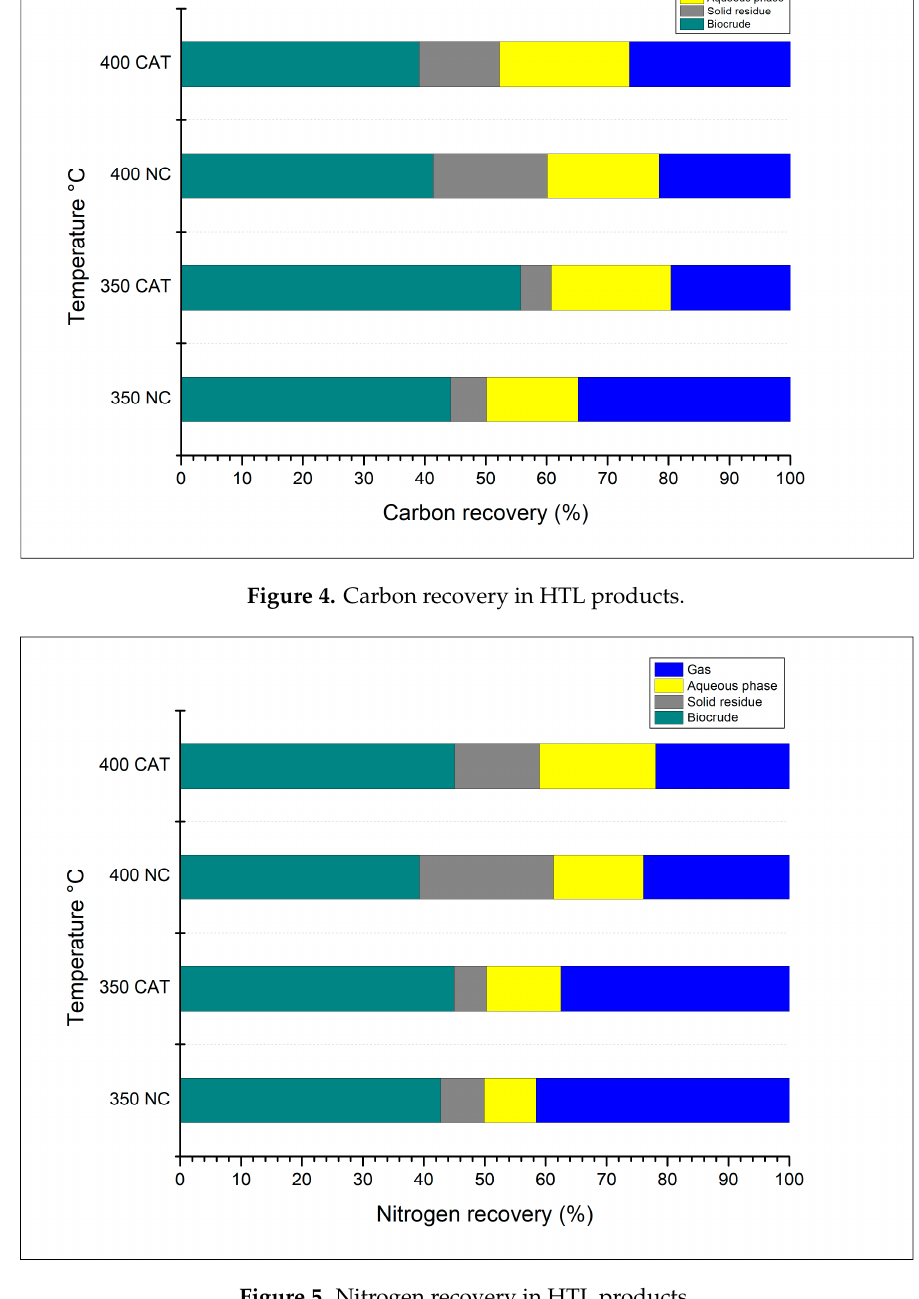
Figure 5. Nitrogen recovery in HTL products.